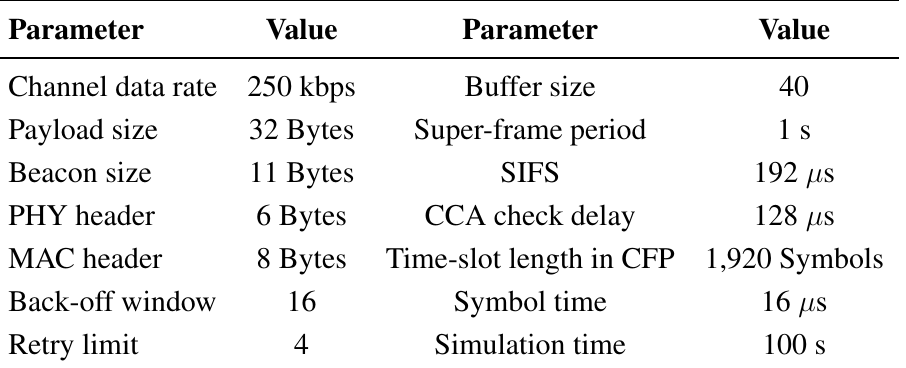
Table 2. Simulation